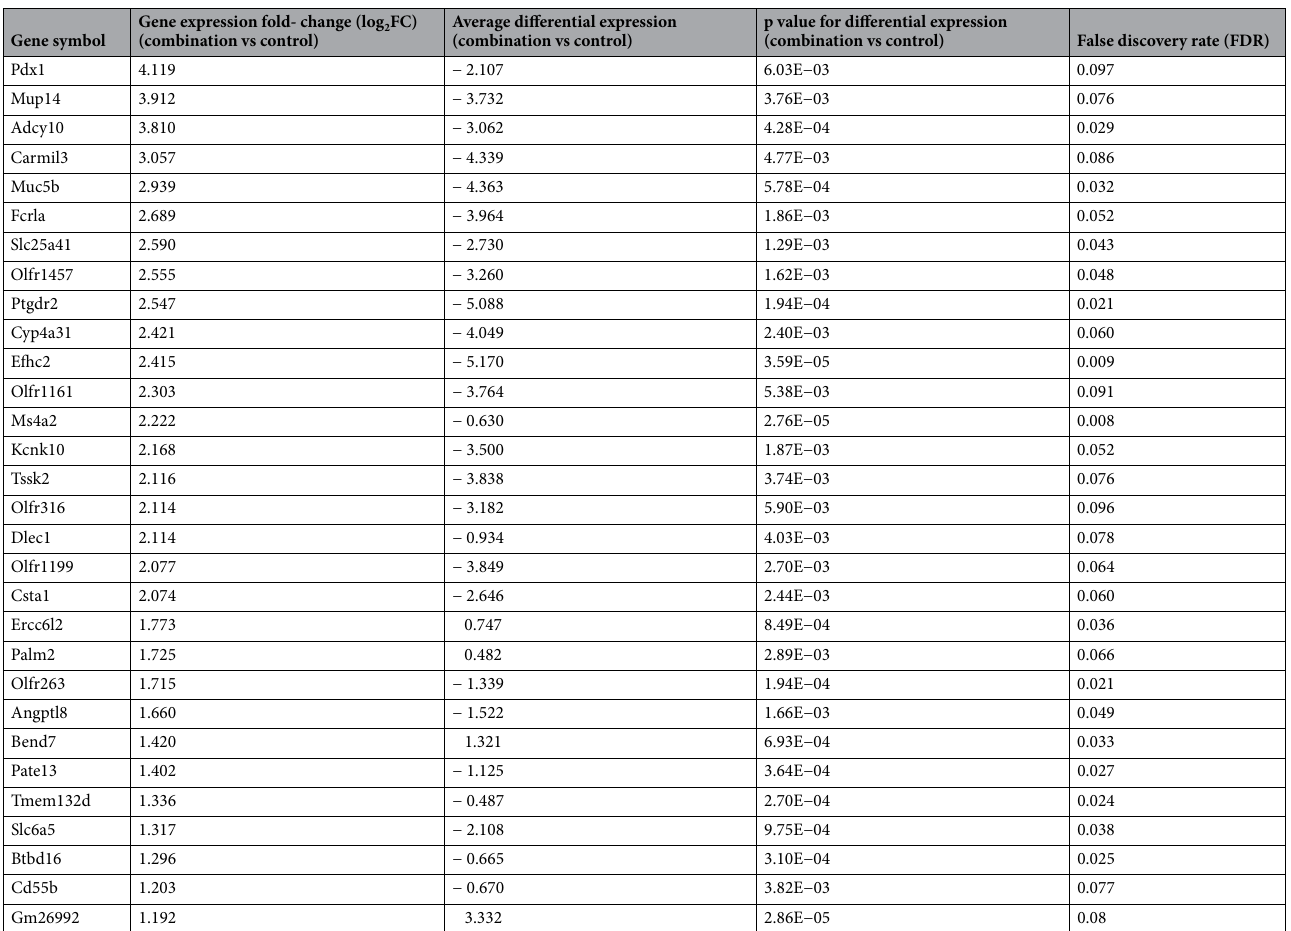
Table 2. Top 30 differentially expressed up-regulated genes in the combination (BSp + GTPs) treatment